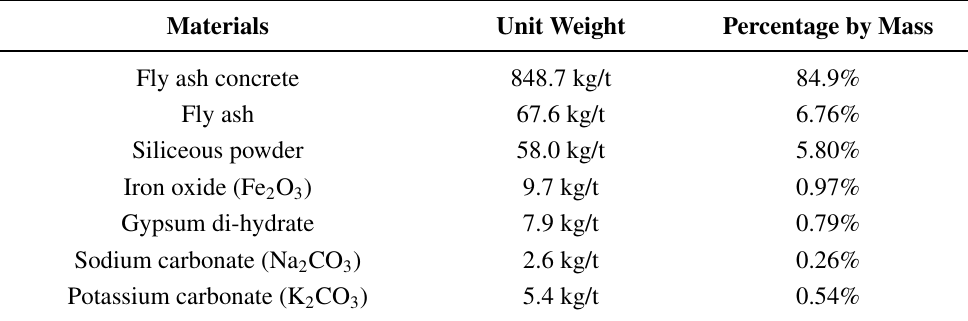
Table 7. Materials for the cement